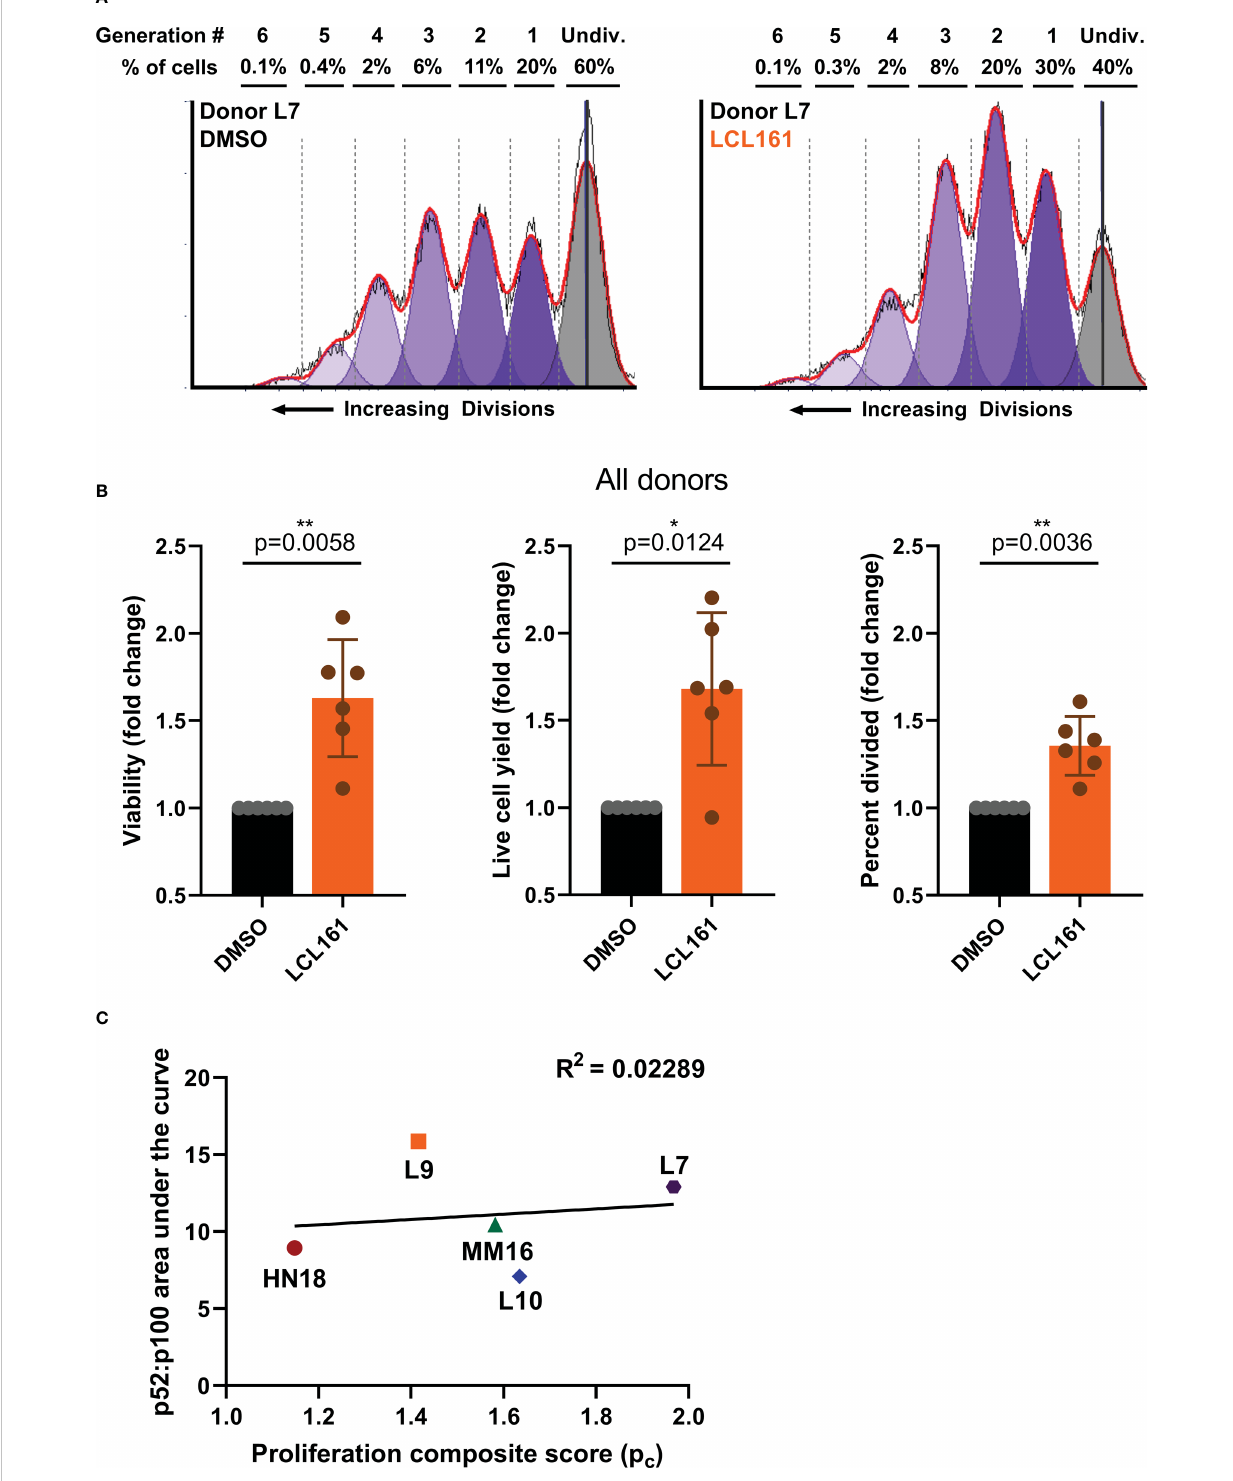
FIGURE 2 LCL161 treatment ampli fi es proliferation and enhances survival of antigen-stimulated TAC T cells. CTV-labelled TAC T cells were stimulated with Protein G polystyrene beads loaded with 50 ng BCMA-Fc/million beads at an E:T of 1:1 for 96 hours in the presence of 0.625 µM LCL161 or DMSO. T cells were harvested and stained for fl ow cytometric analysis. (A) representative fl ow plots with proliferation modeling, and (B) analyzed proliferation data from 5 donors, n=6; *p<0.05, **p<0.01 as calculated by two-tailed paired t test. These data represent 3 independent experiments. (C) Composite proliferation score was calculated as the average of the three proliferation parameters and compared to the area under the curve of the p52:p100 ratio curves in Figure 1C. A simple regression was calculated to determine linear fi